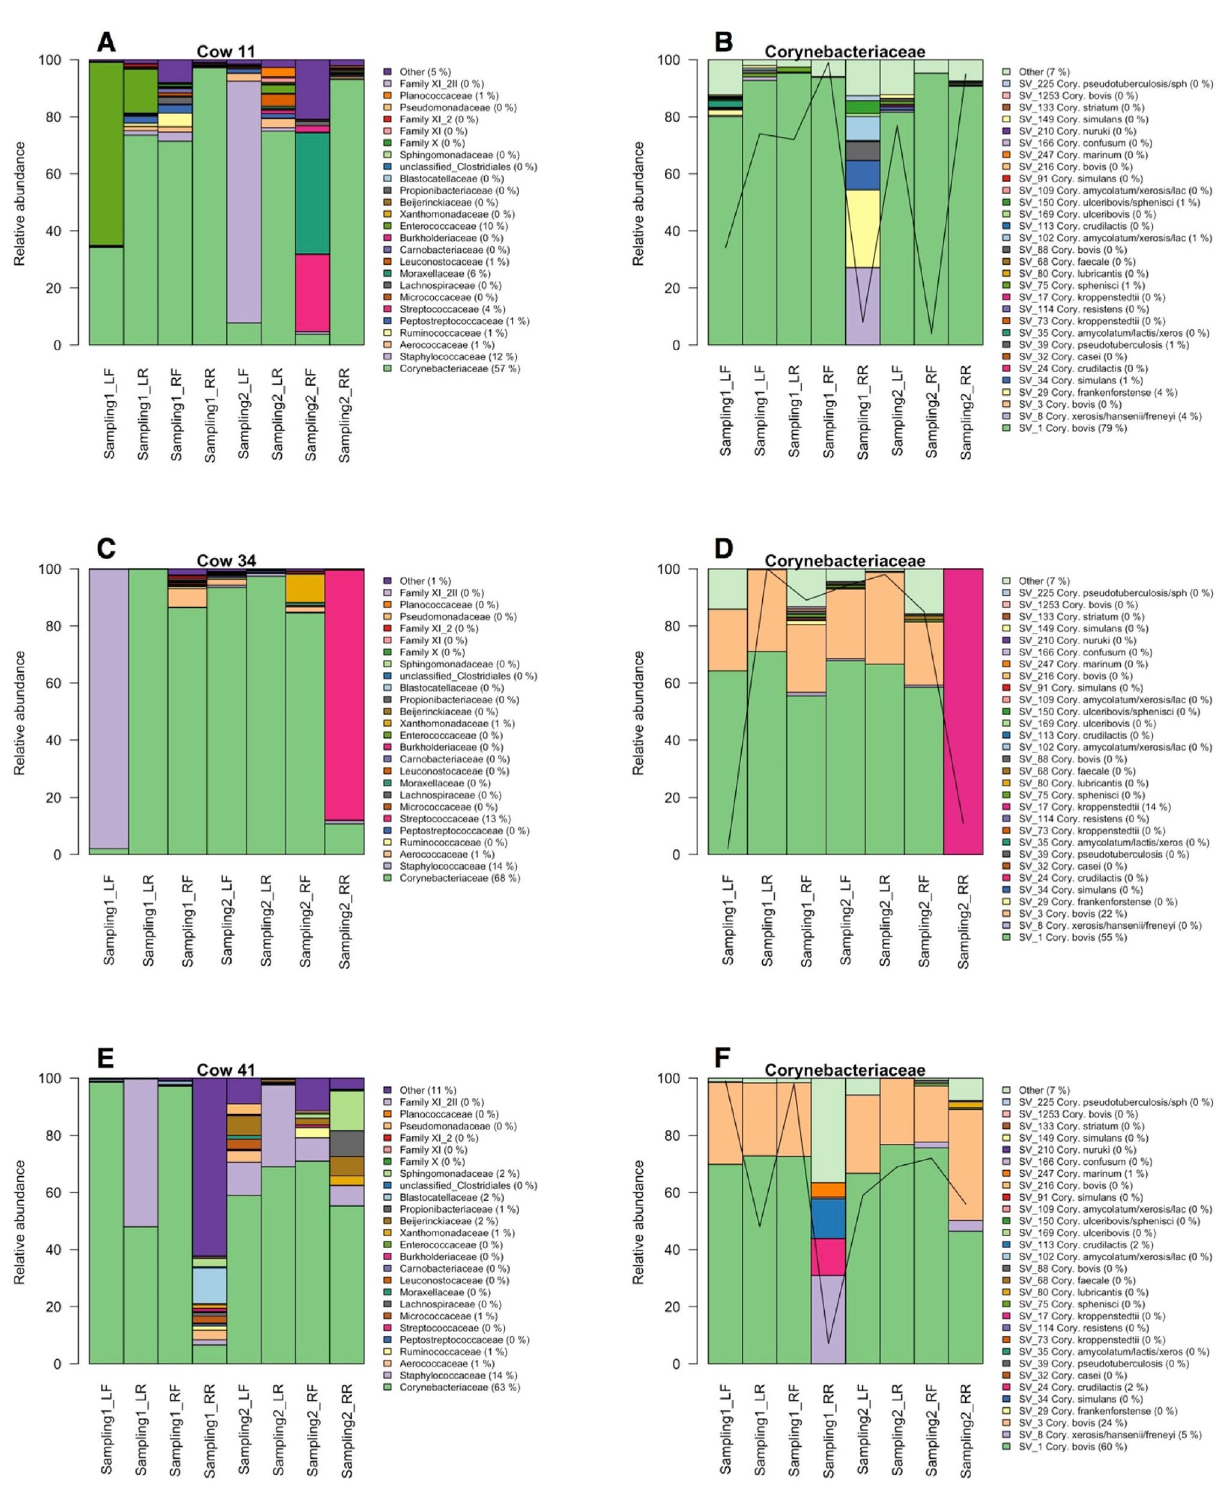
Figure 5. Relative abundance of the quarter microbiota of cow sampled in 2 different occasions ( A , C and E ) and relative abundance of the sequence variants assigned to the family Corynebacteriaceae for the same cows ( B , D and F ). Values after the family and Corynebacteriaceae taxa indicate the percentage abundance over the entire value of the plot. Black lines indicate the relative abundance of the Corynebacteriaceae over the total